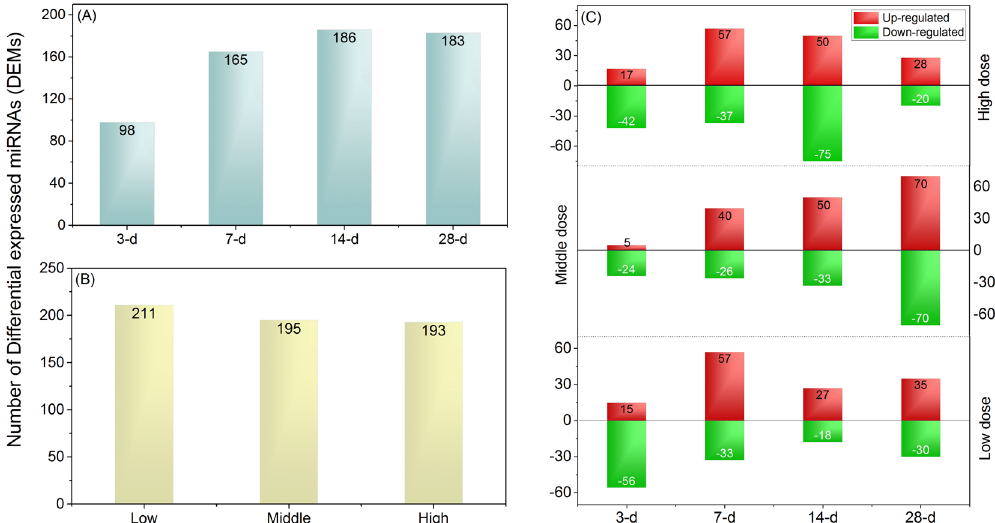
Figure 4. Distribution of DEMs during across all treatment conditions. ( A ) describes an increase in the number of DEMs across four time intervals, ( B ) shows a decreasing in the count of DEMs with increasing dosing from low to high and ( C ) represents the distribution of up-and down-regulated miRNAs at three different doses with four time intervals. X and Y axes represent days and number of DEMs observed during TAA treatment. Red and green color bar plots denote up- and down-regulated miRNAs respectively. From bottom to top, the maximum number of downregulated miRNAs (n = 174; green bars) are observed with low dose compared to middle (n = 153) and high (n = 137) doses, whereas, the highest number of upregulated miRNAs are observed with middle dose (n = 165). Of note, an increase in the number of up- and down-regulated miRNAs is determined at middle dose with all four time points (middle bar plot).